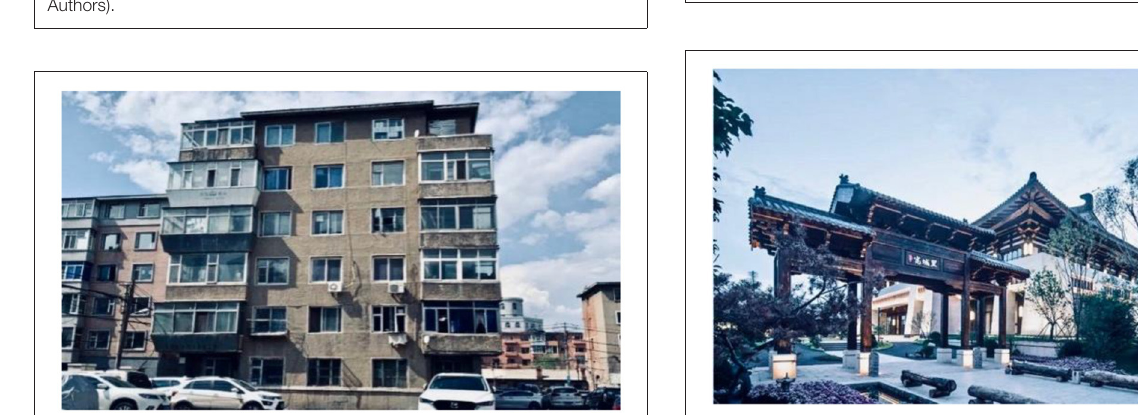
Beihu Wetland Park and other places, and most of the villas are located here.”